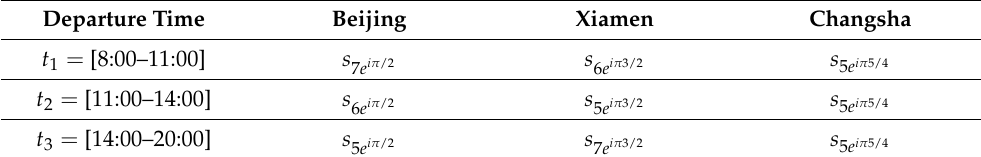
Table 10. Linguistic assessments transformed into